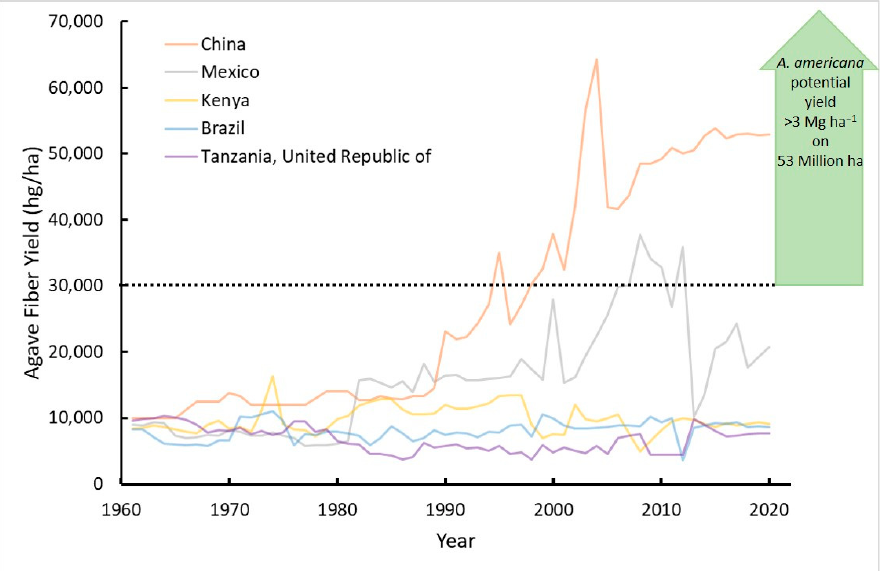
Figure 3. Yield in hg ha − 1 of fibers from four countries with the highest production over time and China, a growing producer in recent years. The green arrow indicates theoretical production of Agave americana. Data reflect production as reported by FAOSTAT [31]. Potential yield of A. americana is based on modeled estimates [14].